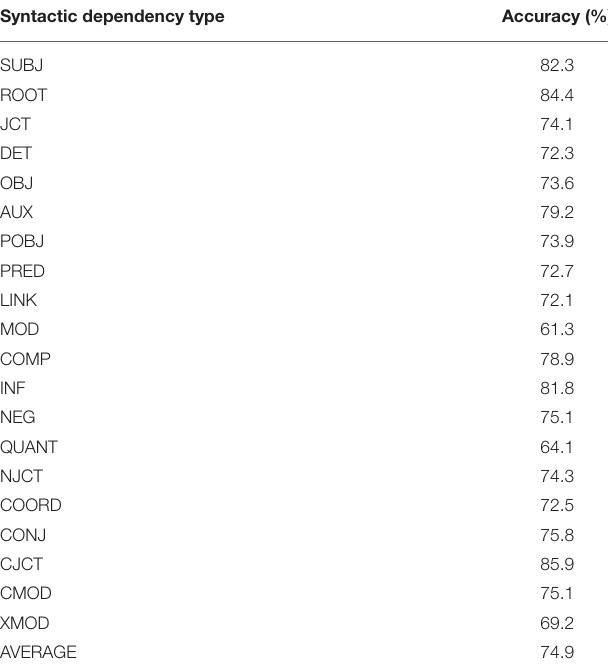
TABLE 2 | Accuracy in detection of the 20 most common syntactic dependency types in our dataset from utterance encodings produced by our model. Syntactic dependency